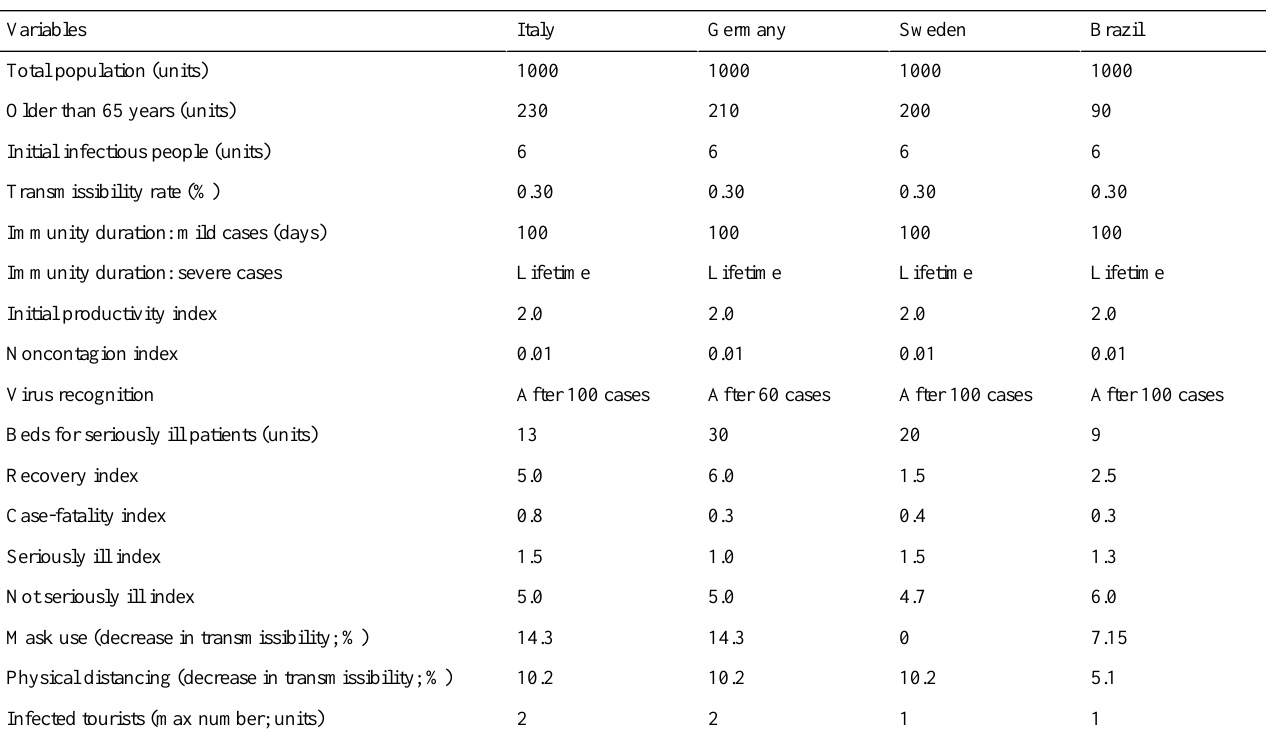
Table 2. List of the model variables. BrazilSwedenGermanyItalyVariables 1000100010001000Total population